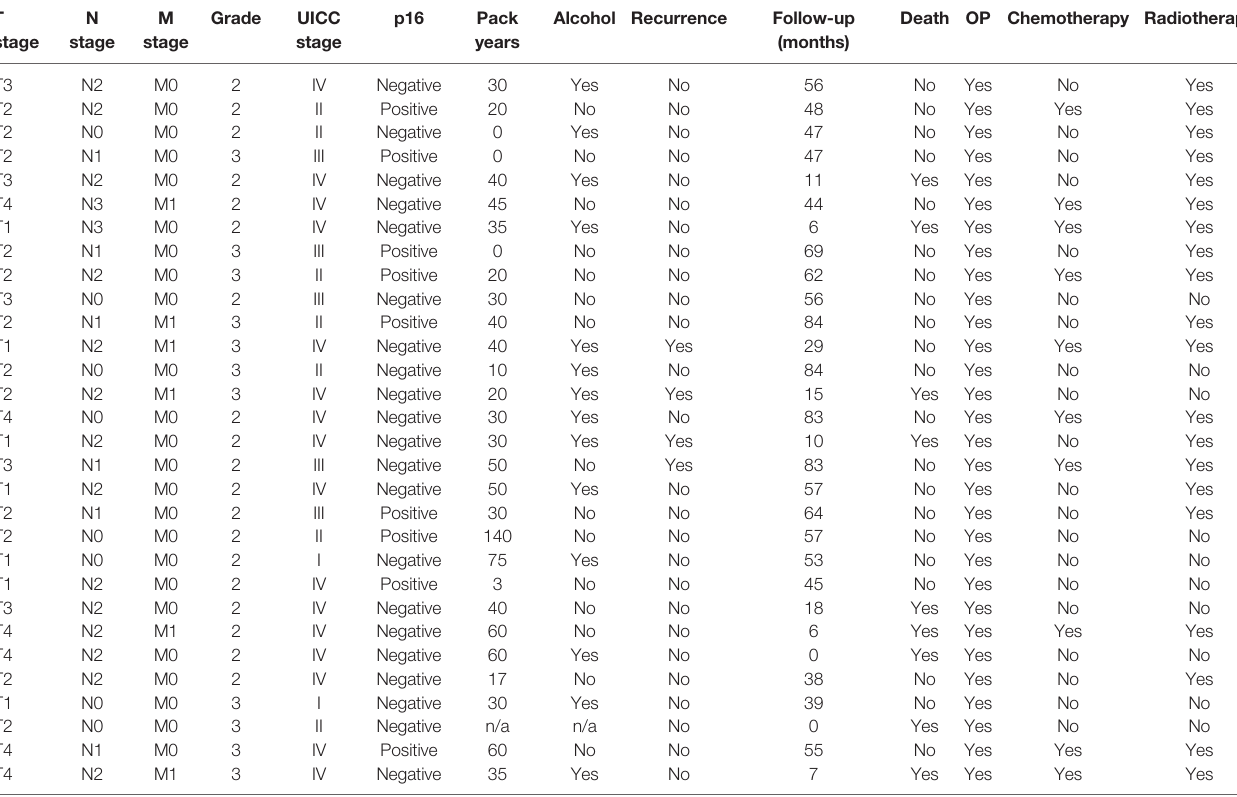
TABLE 2 | Details of all